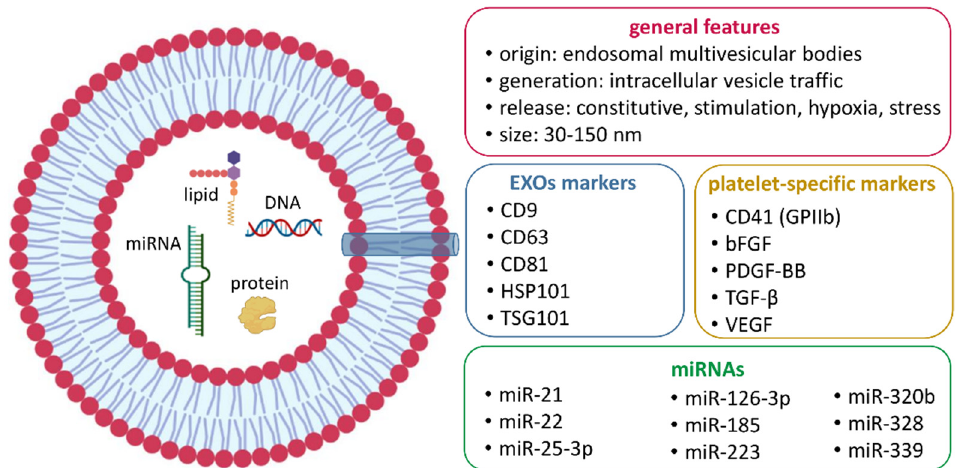
Figure 2. Main characteristics of P-EXOs as detected by transmission electron microcopy (TEM), flow cytometry (FC), Western blot (WB), dynamic light scattering (DLS), and nanoparticle-tracking analysis (NTA).